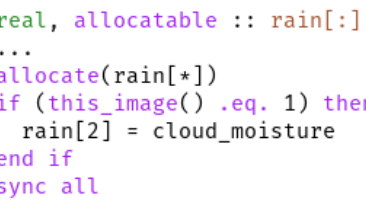
Figure 2. Coarray example of variable